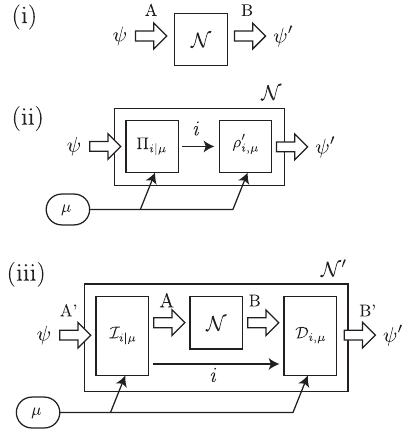
→ D ð H in our resource A Þ B Þ